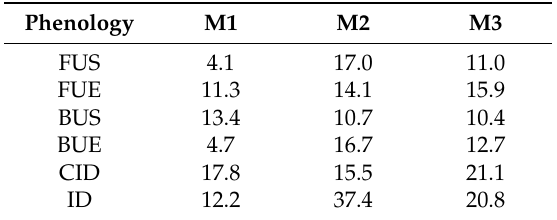
Table 5. Uncertainty of derived lake ice phenology dates assessed by triple collocation approach (RMSE in